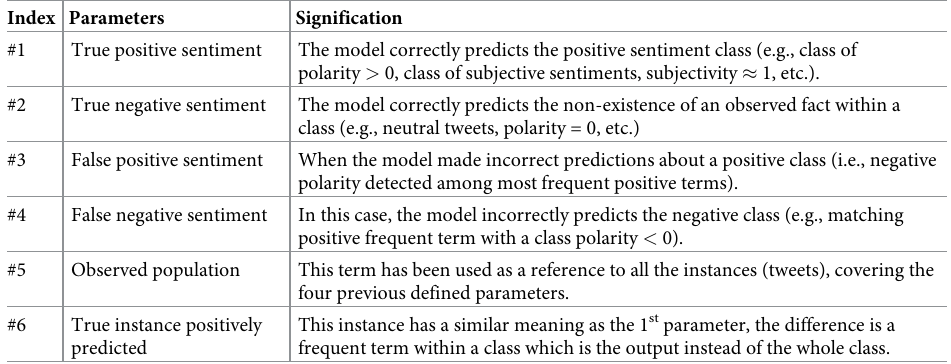
Table 5. Meaning of the learning metrics’ parameters with regards to the SA